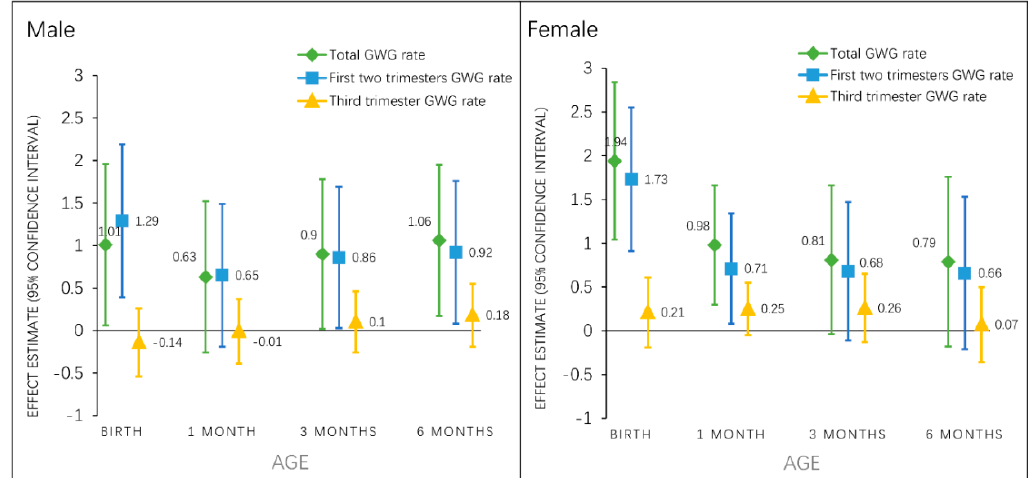
Figure 2. Associations of total and trimester specific GWG rate with sex-specific BMI z-score ( β , 95% CI) from birth to 6 months. Total GWG rate and first two trimesters GWG rate models are adjusted for maternal pre-pregnancy BMI category, age, race, parity, education, family income, smoking status, paternal BMI category; third trimester GWG rate models are further adjusted for gestational diabetes status and the GWG rate in the first two trimesters. Abbreviations: GWG, gestational weight gain; BMIZ, body mass index-for-age z-score.